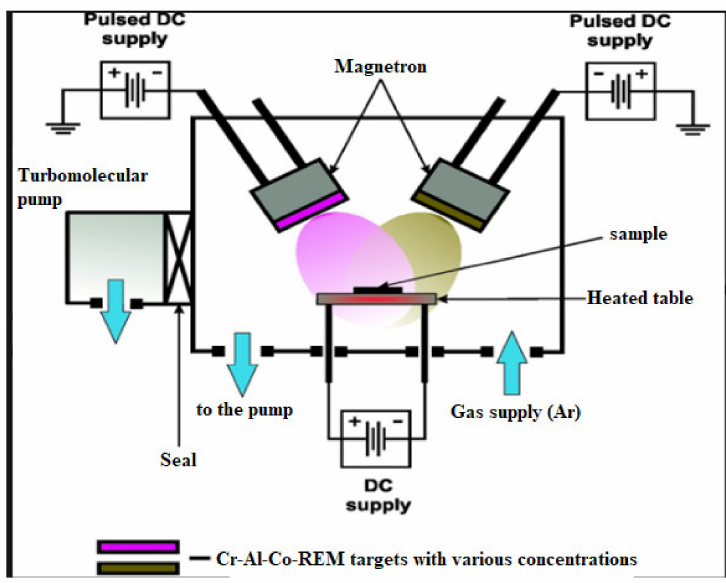
Figure 2. Scheme of the experiment of applying an ion-plasma